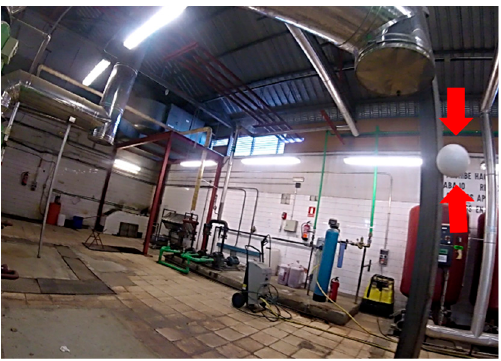
Figure 3. Sphere located in a pillar of the machine room (attached by a neodymium magnet).